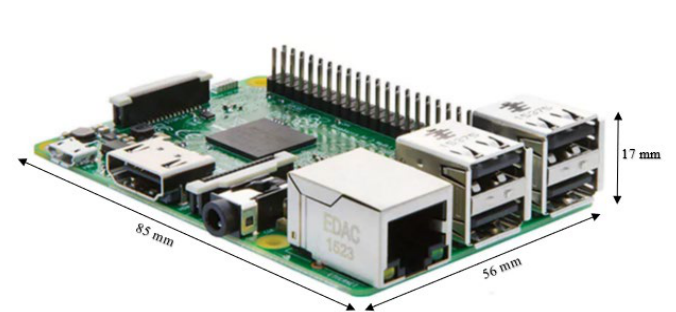
Figure 2. Raspberry Pi